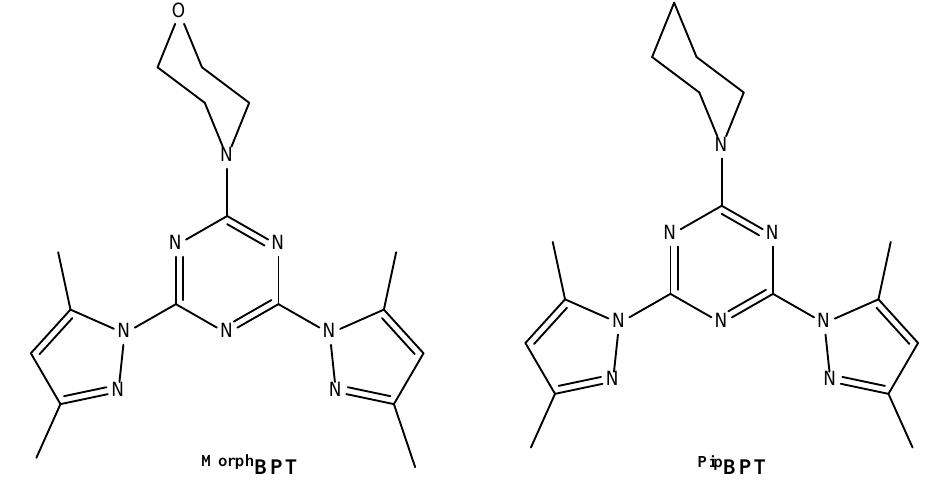
Figure 1. Structure of the pincer ligands [32].